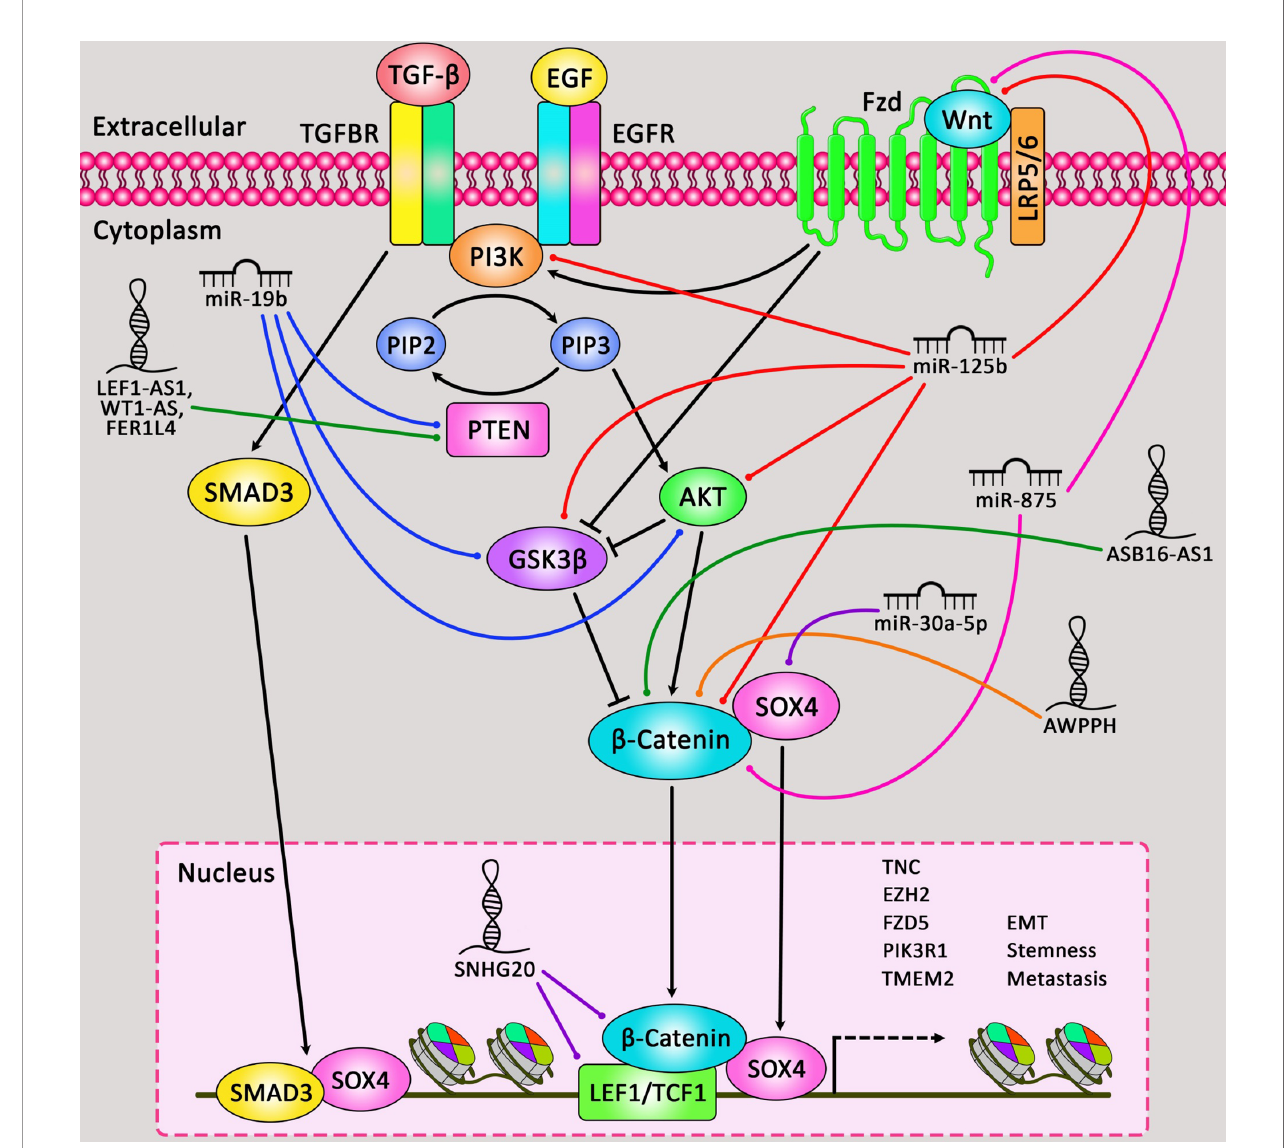
FIGURE 3 | A schematic summary of the role of miRNAs and lncRNAs in regulating apoptosis cascade in lung cancer via Wnt/ b -catenin pathway. Accumulating evidence has delineated that apoptotic cells are negative for b -catenin. This indicates that the Wnt/ b -catenin signaling cascade could be inactive in apoptotic cells. Whilst, b -catenin is expressed in the membrane, cytoplasm, and nucleus of non-apoptotic epithelial cells around these apoptotic cells. Therefore, Wnt/ b -catenin signaling cascade could be activated in non-apoptotic epithelial cells via apoptotic cells (104). As an illustration, downregulation of miR-125b could play an effective role in inhibiting expression of p-Akt, p-GSK3 b , Wnt, and b -catenin, and could promote caspase-3 activity and Bax protein expression in human non-small cell lung cancer. Thereby, this could lead to suppressing the proliferation and triggering the apoptosis of tumor cells (24). Furthermore, another study have illustrated that upregulation of lncRNA SNHG20 could have a crucial part in elevating the proliferation and suppressing the apoptosis of NSCLC cells through targeting miR-197 via regulating the Wnt/ b -catenin signaling cascade. Downregulation of this lncRNA could result in remarkable reduction of TCF and LEF1 expression in the Wnt/ b - catenin pathway